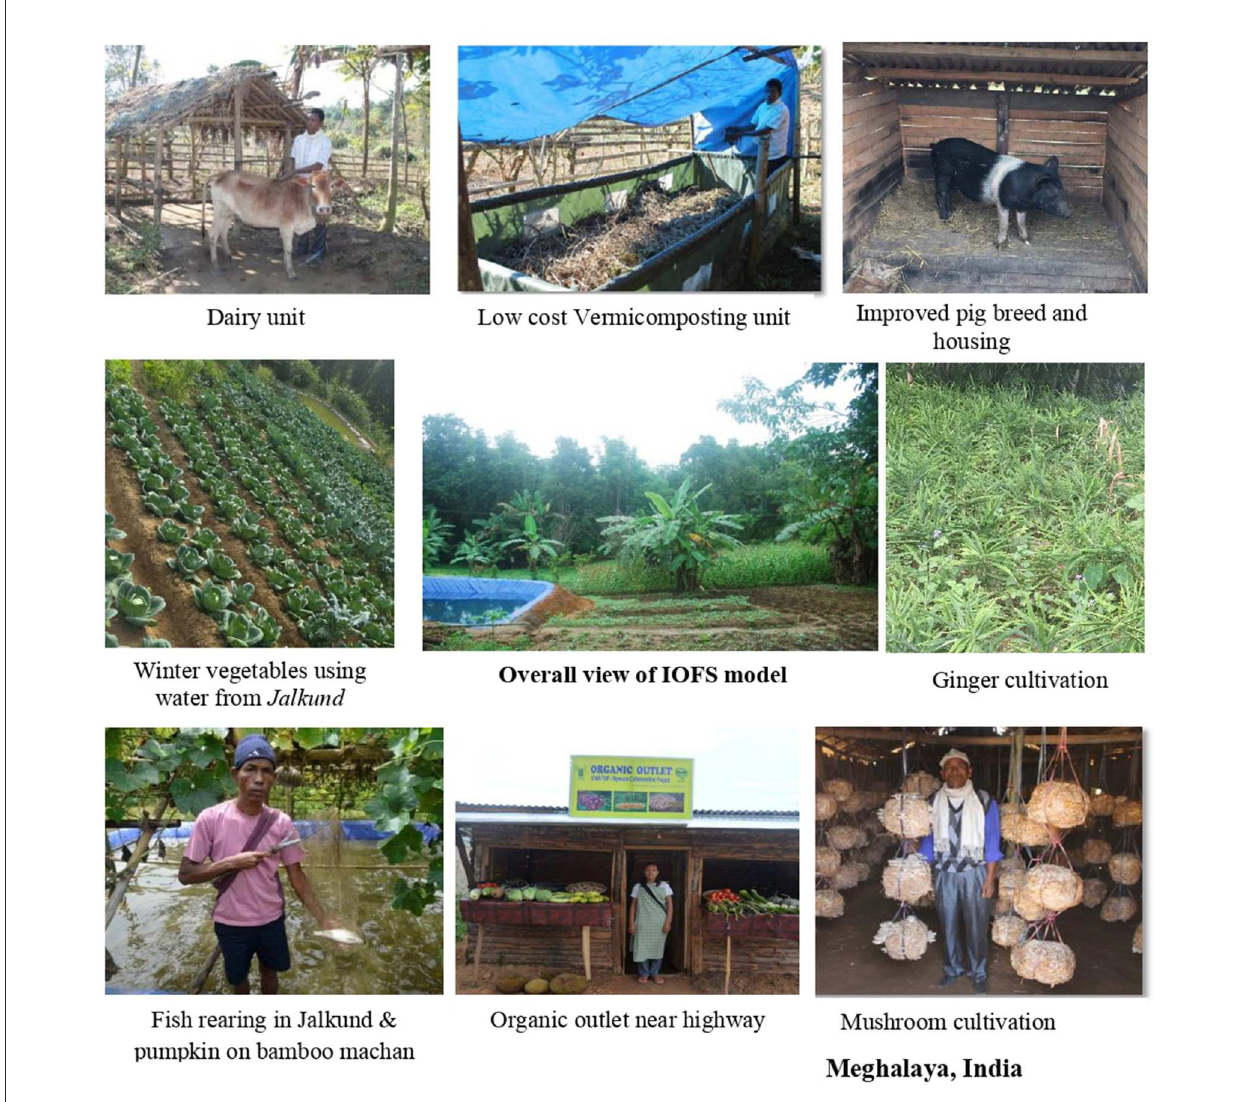
FIGURE3 Different components of the IOFS model developed in the farmers’ fields in Meghalaya,